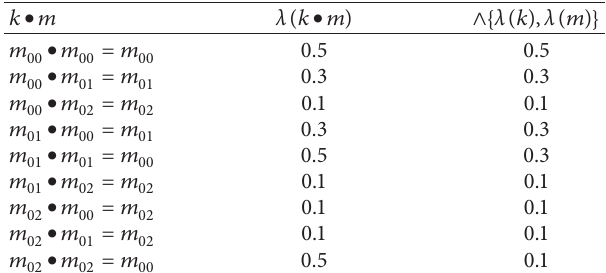
Table 3: λ ( k • m ) ≥ ∧ λ ( k ) , λ ( m ){ }